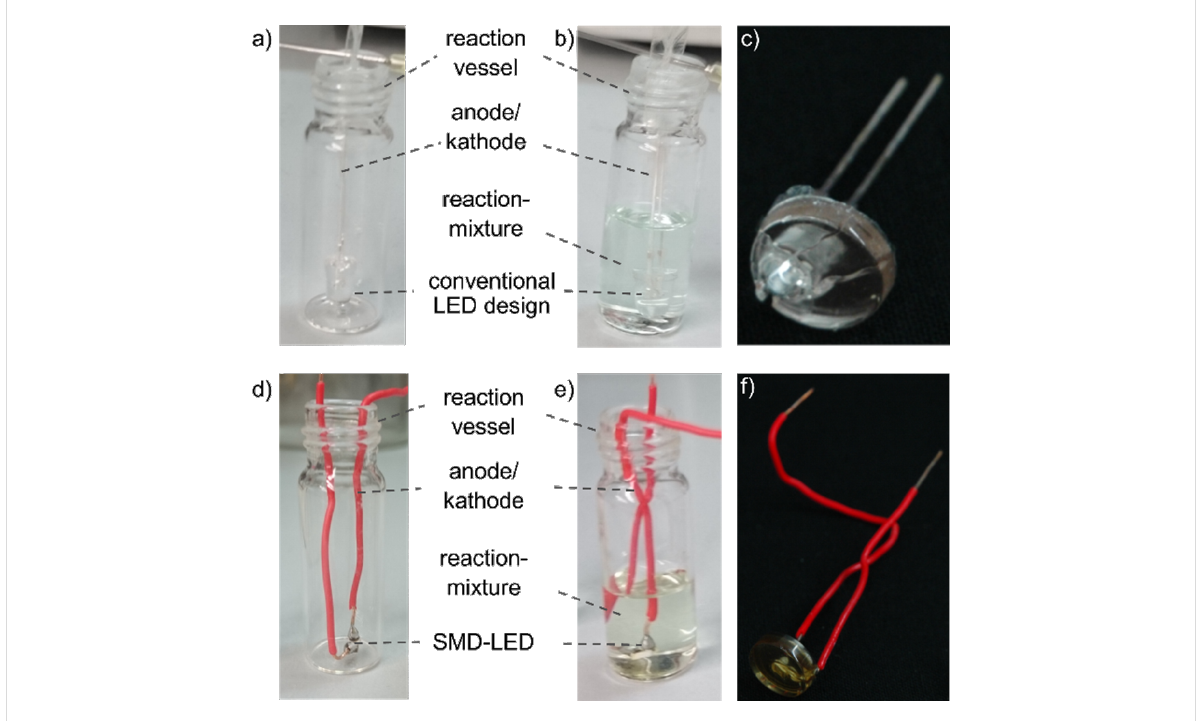
Figure 9: Coating of the a) conventional diode setup and b) surface-mounted device (SMD) (left: prior to the addition of the reaction mixture, right: after the addition), c) coated conventional diode setup, d) coated surface-mounted device.